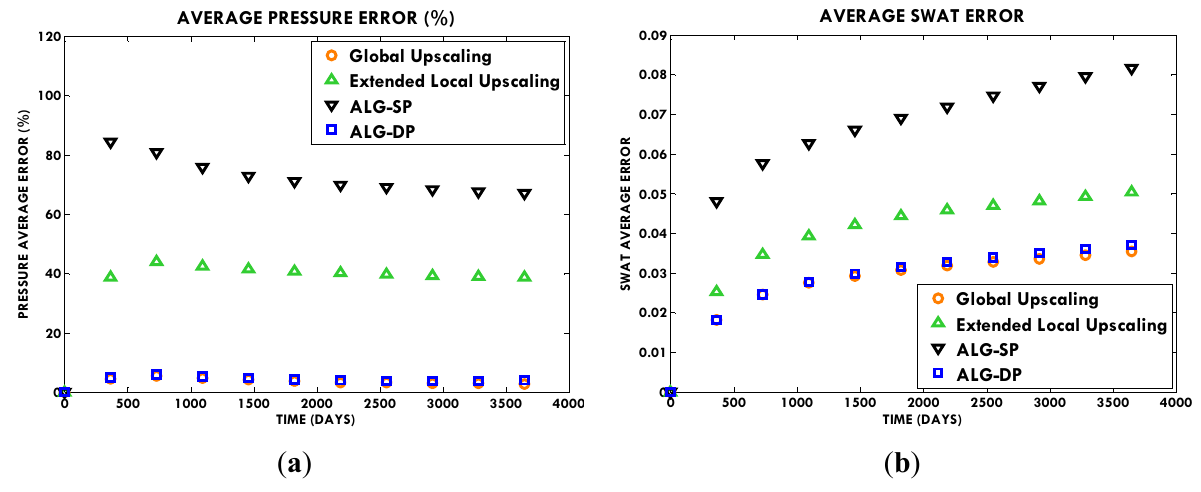
Figure 8. Average field error comparison for case 1: ( a ) pressure error; ( b ) water saturation (SWAT)